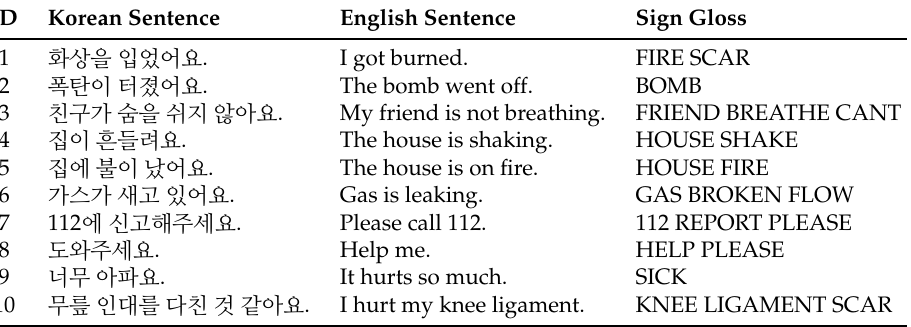
Table 2. Ten examples of our sign language annotations. We annotated each sign with five natural language sentences in Korean and a unique sign gloss. We only provide two sentences in the table due to space